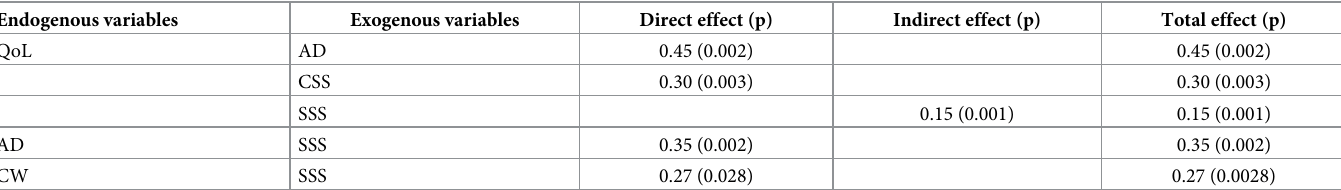
Table 3. Summary of the direct, indirect and total effects of significant factors on social support, frailty and quality of life among haemodialysis patients. Endogenous